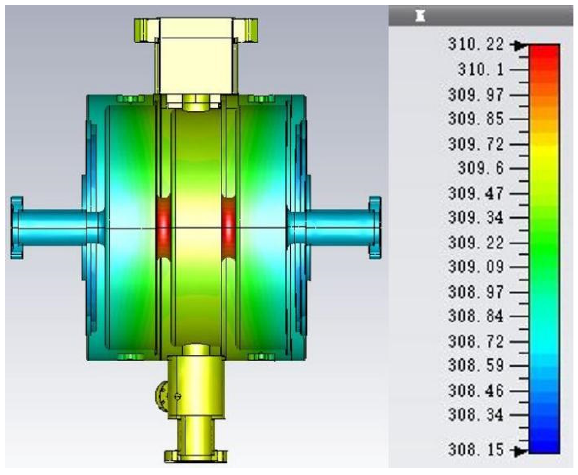
Figure 9. Temperature distribution of the cavity with water